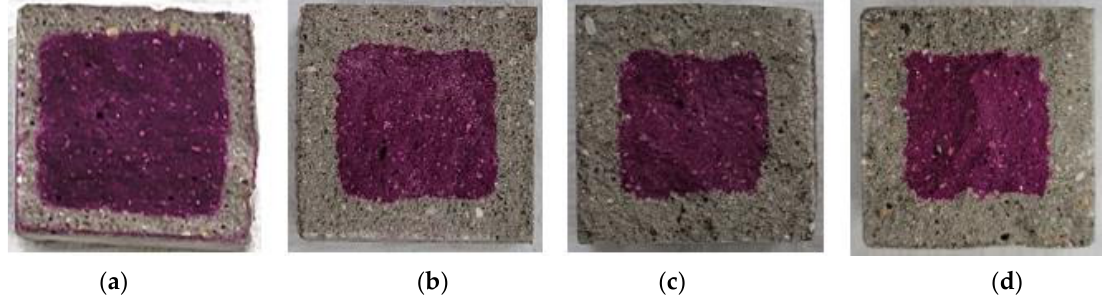
Figure 9. Accelerated carbonation test result of OPC: ( a ) 1, ( b ) 2, ( c ) 3, and ( d ) 4 weeks.